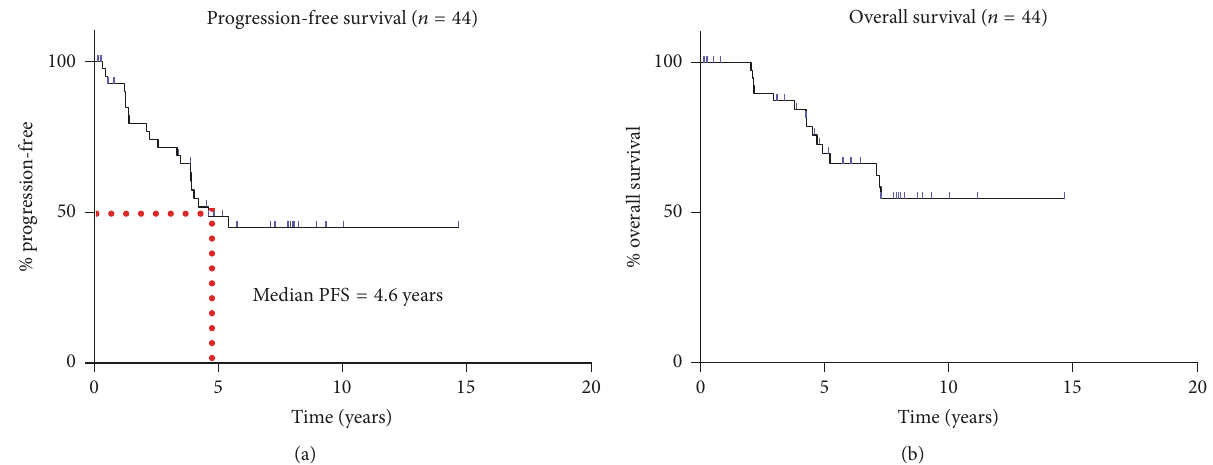
Figure 1: Kaplan-Meier survival curves showing PFS (a) and OS (b) for the entire cohort ( 𝑛 = 44 ) of head and neck synovial sarcoma patients. The median PFS was 4.6 years. Median OS not reached.